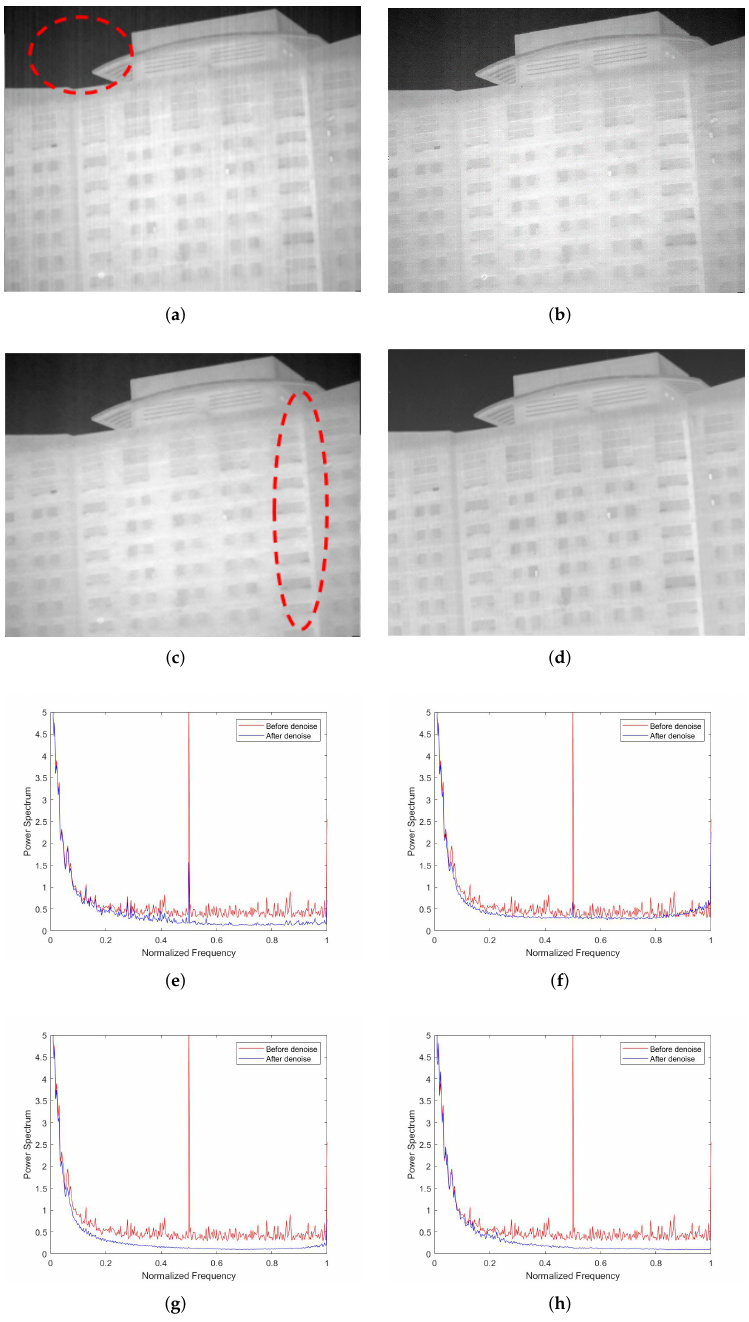
Figure 13. Denoising effects of different methods on an image of a single building : (a) MSGF; (b) WAGE; (c) TVGF; (d) our approach; (e) MSGF; (f) WAGE; (g) TVGF; (h) our approach.